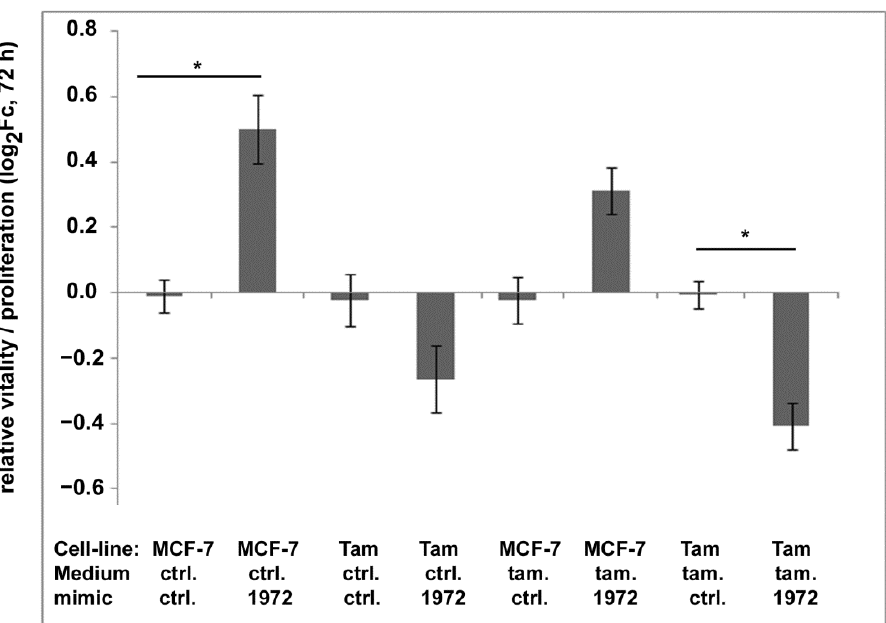
Figure 8. Impact of transfection with the miR-1972 mimic on viability/proliferation of MCF-7- and MCF-7-Tam cells in normal medium and medium containing 4OH-tamoxifen (10 nM). Cell viability/proliferation was determined using the resazurin assay. The fluorescence signal was normalized to the signal after seeding and shown relative to control transfections as log 2 Fc. * indicates significant differences to the control transfection determined by ANOVA and Tamhane-T2 post-hoc test ( p < 0.05). The experiments were performed three times with 3 to 4 replicas each. In scratch experiments, MCF-7 cells did migrate faster than the MCF-7-TamR cells. In addition, MCF-7 cells did not show a statistically significant change in migration, whereas MCF-7-TamR cells exhibited an even reduced scratch closure (Figure